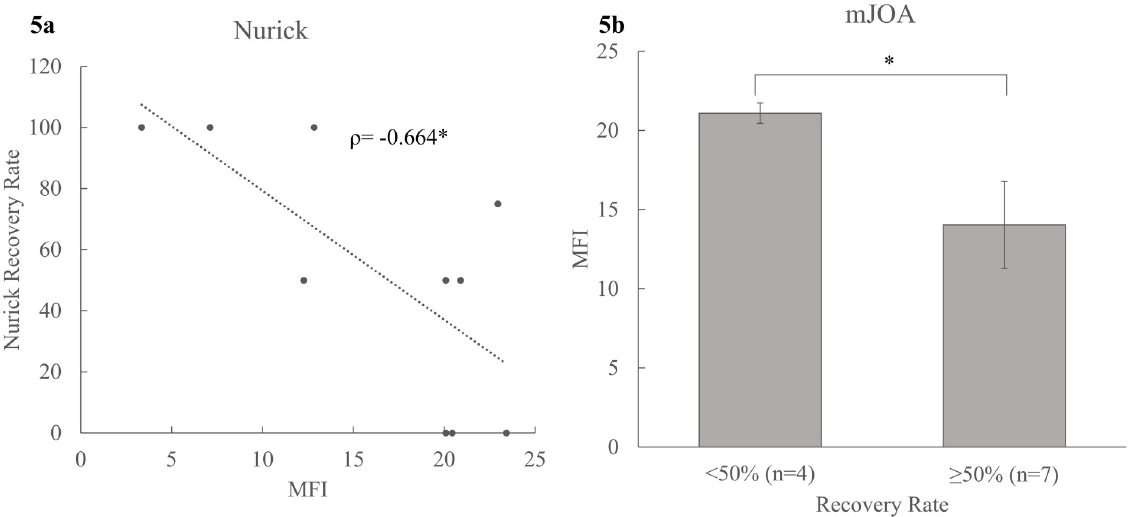
Fig 5. Association between pre-surgical MFI and post-surgical functional improvement in clinical disability. a) Scatterplot depicting relation between MFI and Nurick recovery rate, Spearman’s ρ is reported; b) Mean group differences in MFI across mJOA recovery rate dichotomized as < 50% and � 50%. Mean (SE) are reported. � denotes significance at p � 0.05. MFI = muscle fat infiltration, LC = longus colli and longus capitis, mJOA = modified Japanese Orthopedic Association.